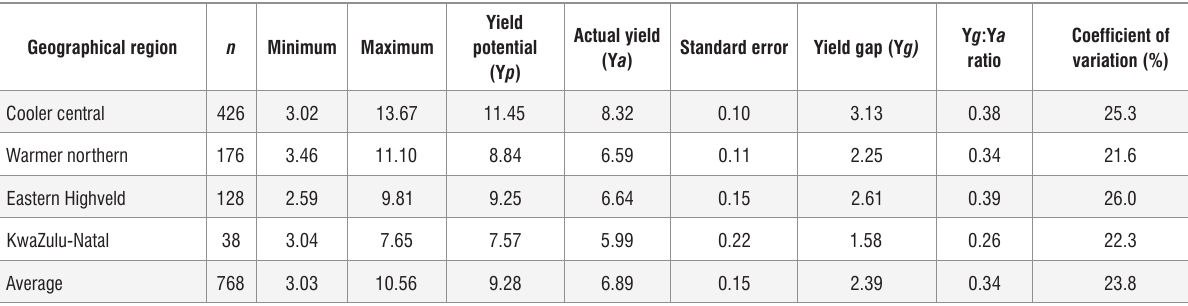
Table 1: Actual yields, yield potentials and yield gaps (t/ha) for irrigated wheat in South Africa